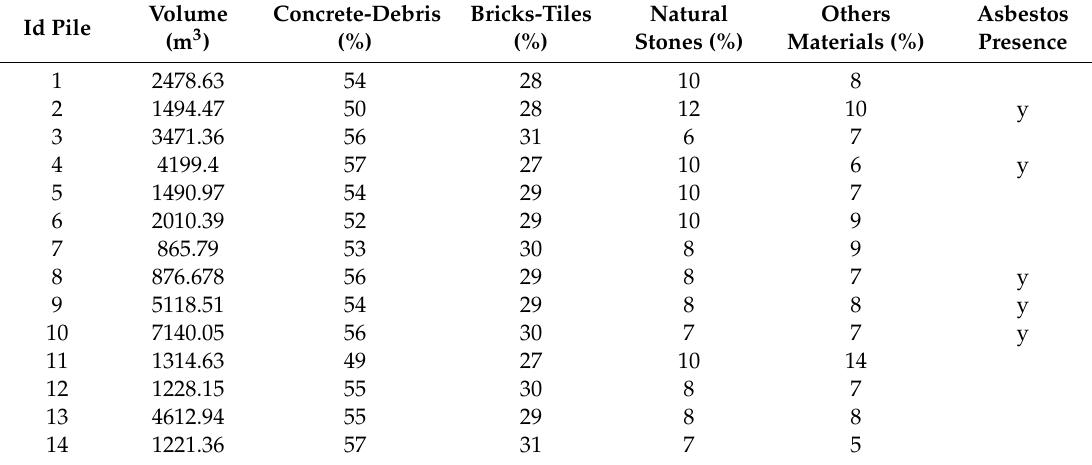
Table 7. Volumes and main constituents (for a sample of rubble heaps located in the most affected area). For each heap the asbestos’ presence is also indicated.